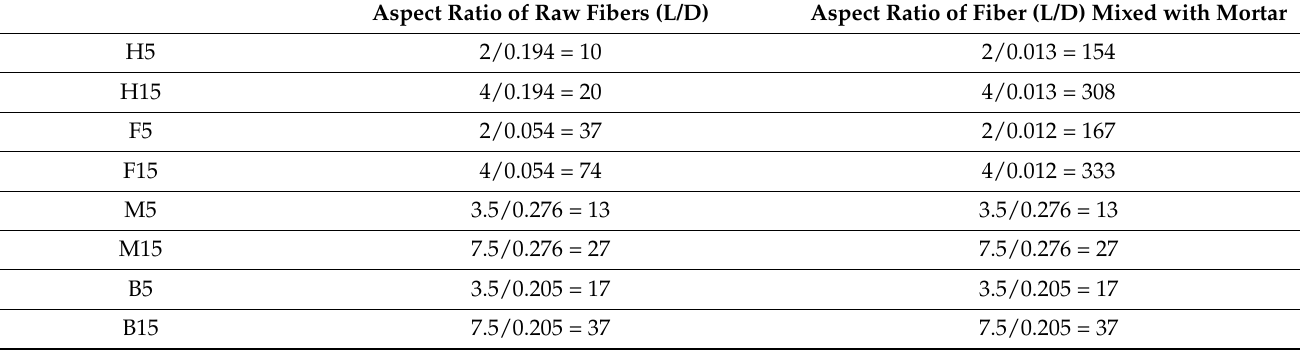
Table 6. Aspect ratio of the